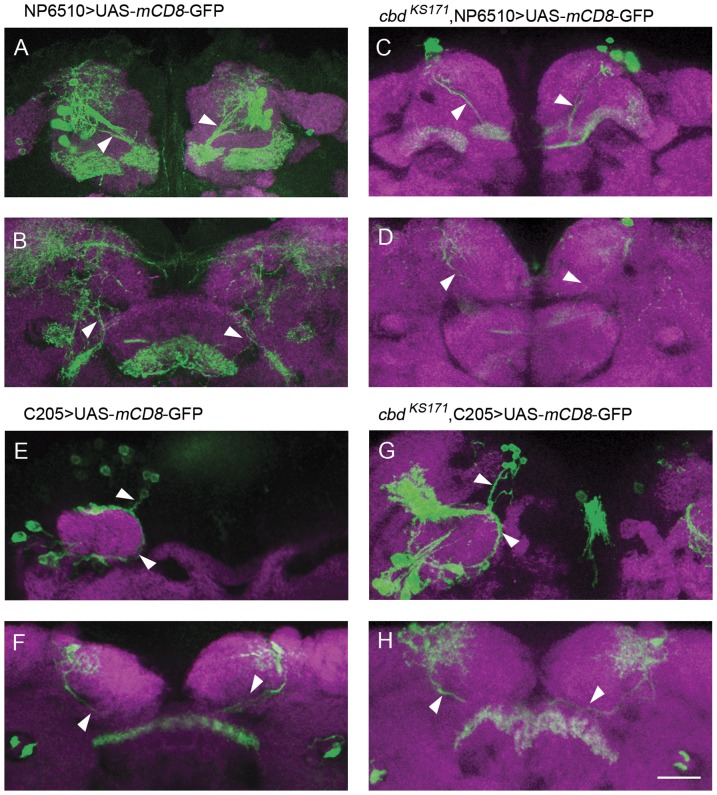
The projection tracts of both F1 neurons and F5 neurons appeared to be normal in cbd KS171 mutants.(A–D) Neural projection and arborizations of F1 neurons in wild type flies and cbd KS171 mutants. (E–H) Neural projection and arborizations of F5 neurons in wild type flies and cbd KS171 mutants. Scale bar, 25 µm. Arrowheads indicate the normal neural projection.